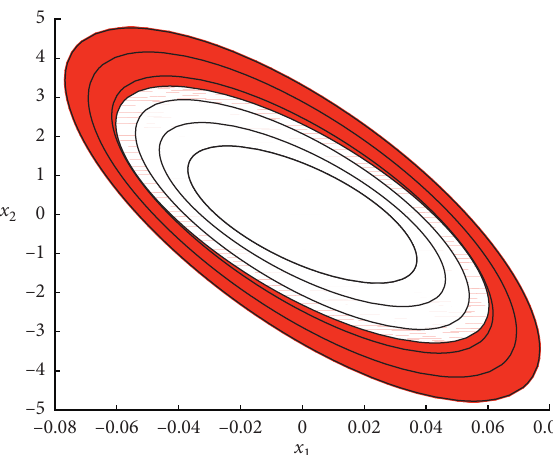
Figure 2: Resulting maximized ellipsoidal invariant sets (in red).